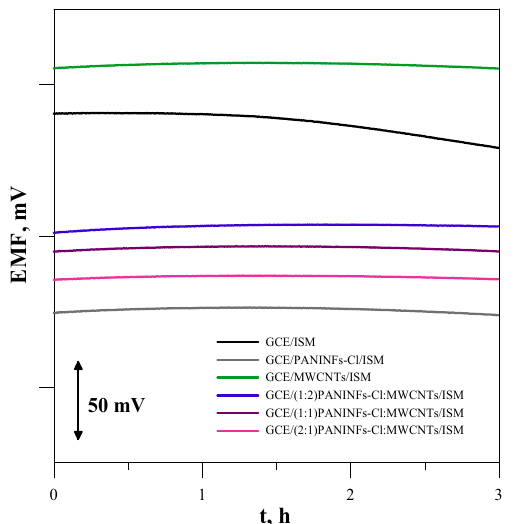
Figure 7. The short-term potential stability measured in 10 − 3 mol L − 1 NaCl. Table 5. Reversibility and short-term stability of the electrode potential determined in NaCl solu- tions with a concentration of 10 − 4 and 10 − 3 mol L − 1 . Mean values and standard deviation obtained for 5 results.